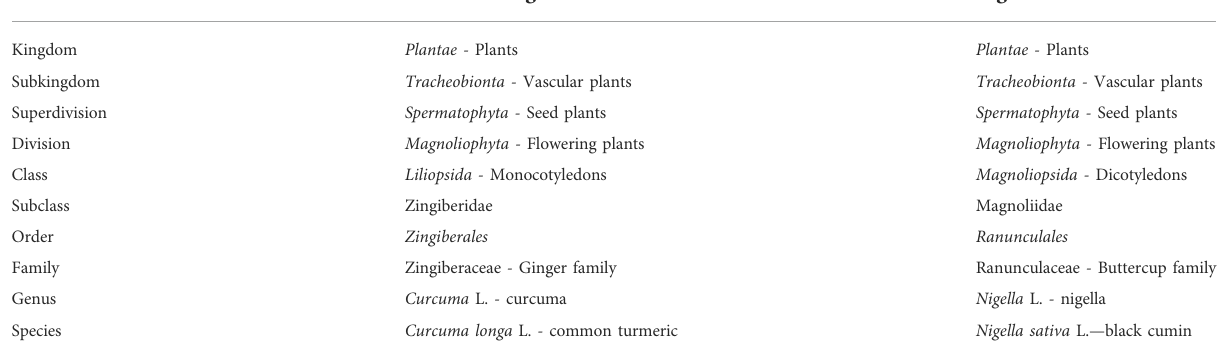
TABLE 1 Taxonomic hierarchy of Curcuma longa L. and Nigella sativa